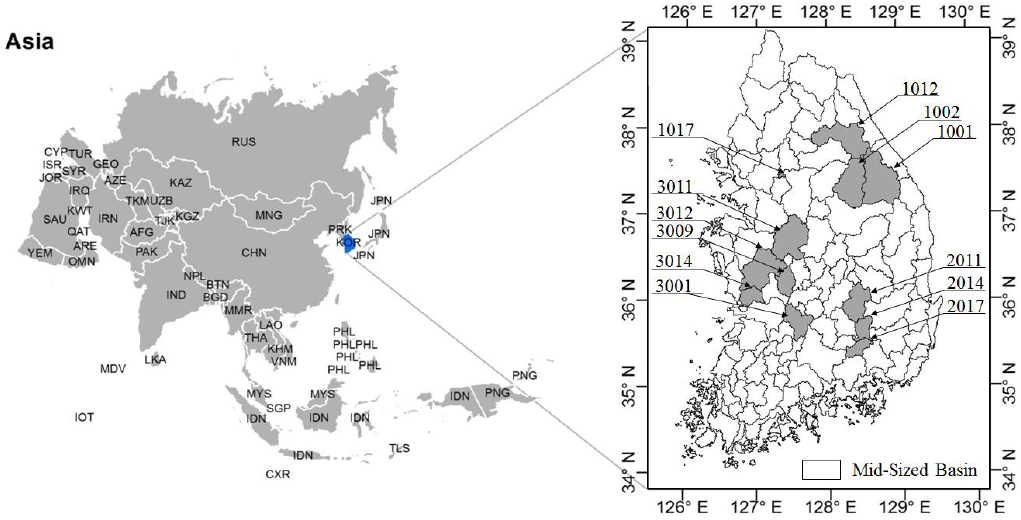
Figure 1. Study areas.